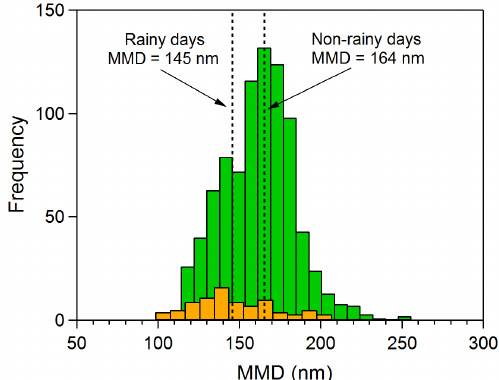
Figure 7. Frequency distributions of mass median diame- ters (MMDs) for rainy and non-rainy sampling days. The vertical dashed lines denote the average MMDs for those two types of